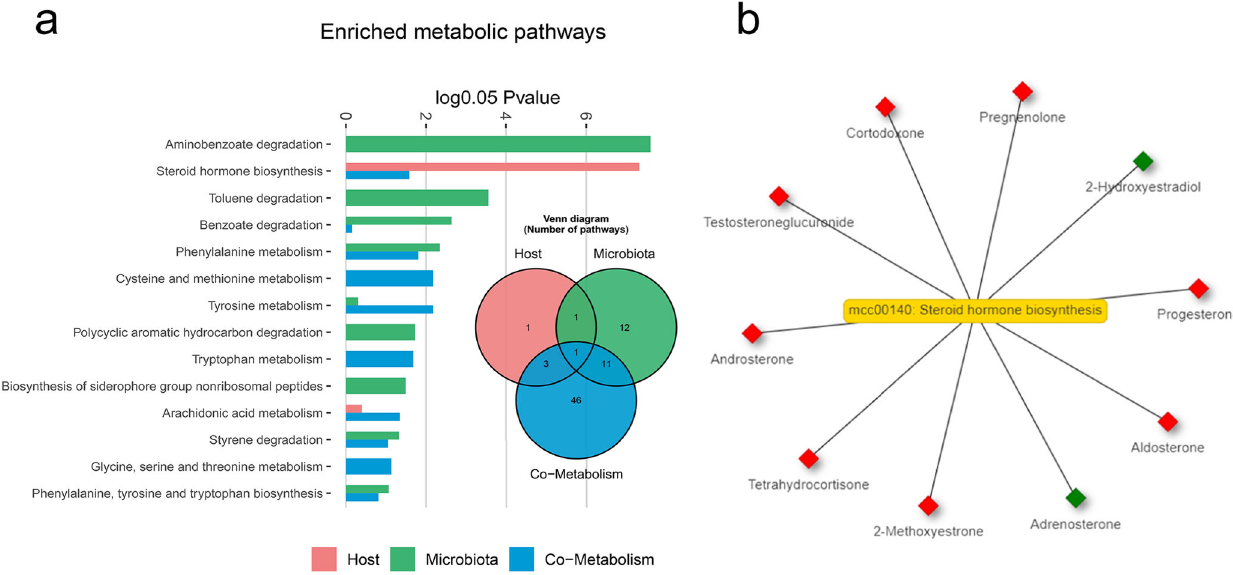
Fig. 5 Comparison of KEGG pathways corresponding to differential metabolites of different origins. a Statistically signi fi cant comparisons of metabolic pathways (Hypergeometric test, log0.05 P value > 1); b Network plots obtained based on the Metorigin platform showed statistically signi fi cant steroid hormone biosynthesis (ko00140) related metabolites in the host ’ s own metabolism. Boxes indicate metabolites, red indicates signi fi cantly higher abundance in high-altitude populations than in low-altitude populations, and green indicates signi fi cantly higher abundance in low-altitude populations than in high-altitude